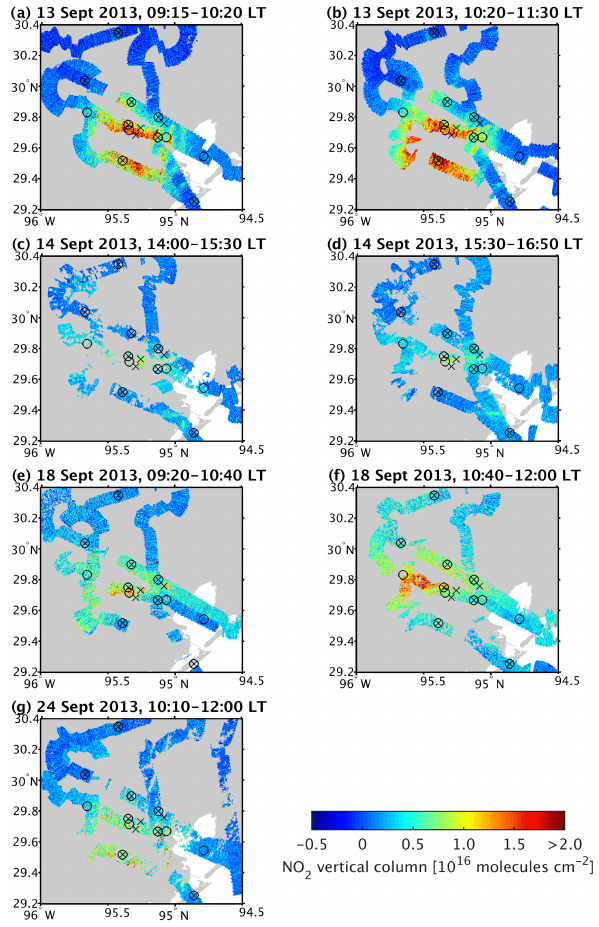
Figure 11. GeoTASO NO 2 tropospheric vertical columns at 250m × 250m resolution with a precision of 2 . 2 × 10 15 moleculescm − 2 , retrieved for cloud-free observations over Houston during the DISCOVER-AQ campaign. Columns determined from fewer than 20 co-added native pixels (uncer- tainty > 5 × 10 15 moleculescm − 2 ) are excluded. Locations of DISCOVER-AQ science ground sites are shown with black circles, and locations of TCEQ SLAMS in situ monitors are shown with black crosses.